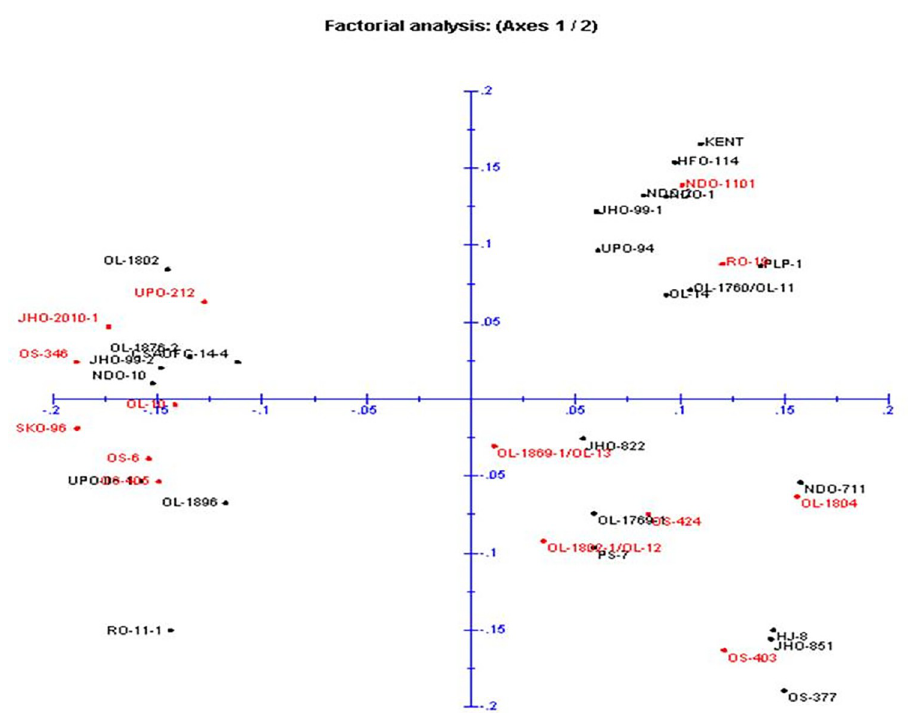
Fig 3. Inter Simple Sequence Repeats (SSR) marker-based principal component analysis showing two- dimensional distributions of oat germplasms.